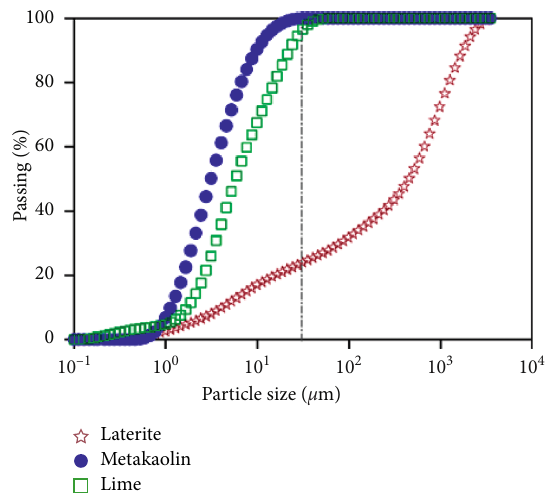
Figure 2: Particle size distribution curves of testing